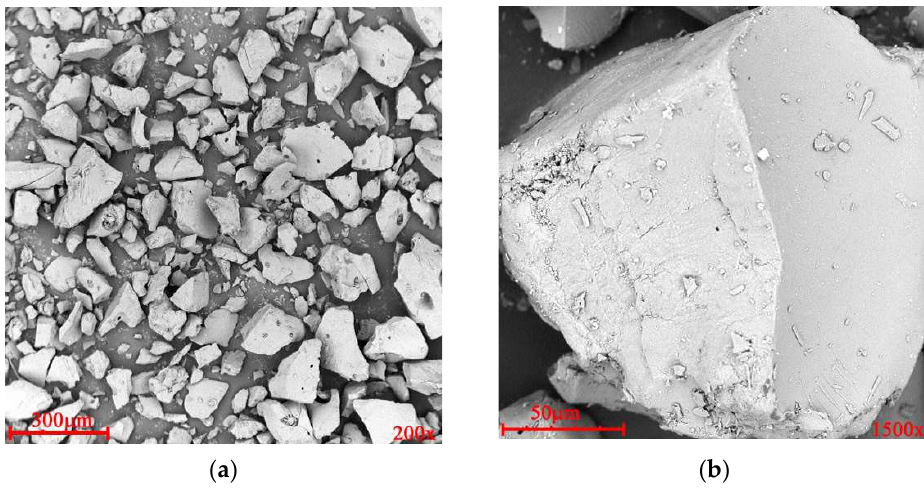
Figure 1. Microscopic images of the quaripolymer particles: ( a ) 200 times, ( b ) 1500 times. The FT-IR spectrum of the quadripolymer is presented in Figure 2. Moreover, 3444 cm − 1 and 3300 cm − 1 are assigned to the N-H stretching vibration of AM and AMPS, respectively. The absorbency at 2935 cm − 1 results from the characteristic peak of the methyl group. The stretching vibration of C=O at 1699 cm − 1 is attributed to AM and AMPS. The absorption peak observed at 1454 cm − 1 is due to the C-H bending vibration from DMDAAC unit. Bands recorded at 1185 cm − 1 and 1044 cm − 1 assigned to S=O stretching vibration in the sulfonic group correspond to SSS unit. The absorption peaks at 766 cm − 1 reveal the bending vibration of a benzene ring of the SSS unit.